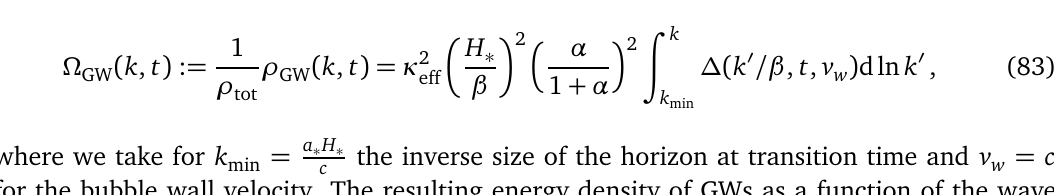
Figure 5: The integrated dimensionless power spectrum of GWs sourced by a FPT. The spectrum is evaluated in the middle of the phase transition τ shows the horizon mode and the pink dashed dotted line indicates the peak wave number of the logarithmic GW abundance. We chose β/ H ∗ = 1 for demonstration